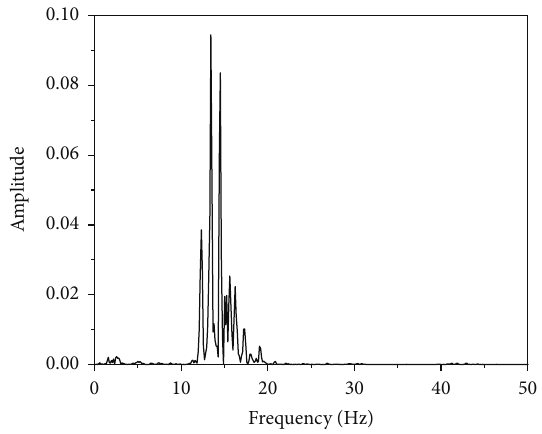
Figure 18: FFT of the acceleration responses at the trailing edge of the aileron with the airspeed of